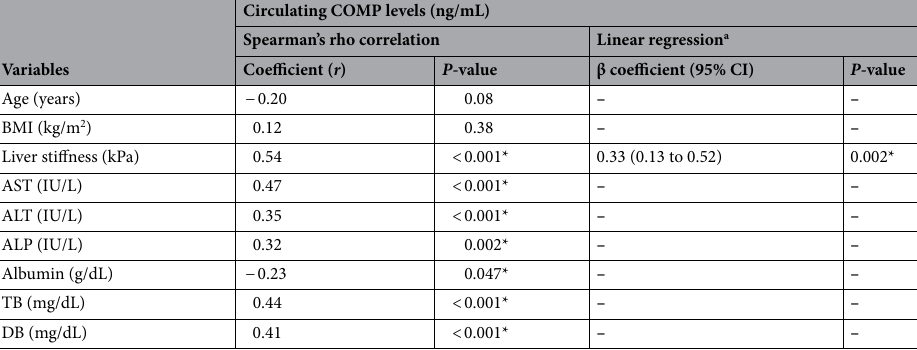
Table 2. Spearman’s rho correlation and multivariate linear regression analyses determining associations between circulating COMP levels and clinical parameters in BA patients. ALP alkaline phosphatase, ALT alanine aminotransferase, APRI AST to platelet ratio index, AST aspartate aminotransferase, BA biliary atresia, BMI body mass index, DB direct bilirubin, TB total bilirubin, NA not available. *Correlation is considered statistically significant at P -value less than 0.05 (two-tailed). a The coefficient was adjusted for age, BMI, AST, ALT, ALP, albumin, TB, and